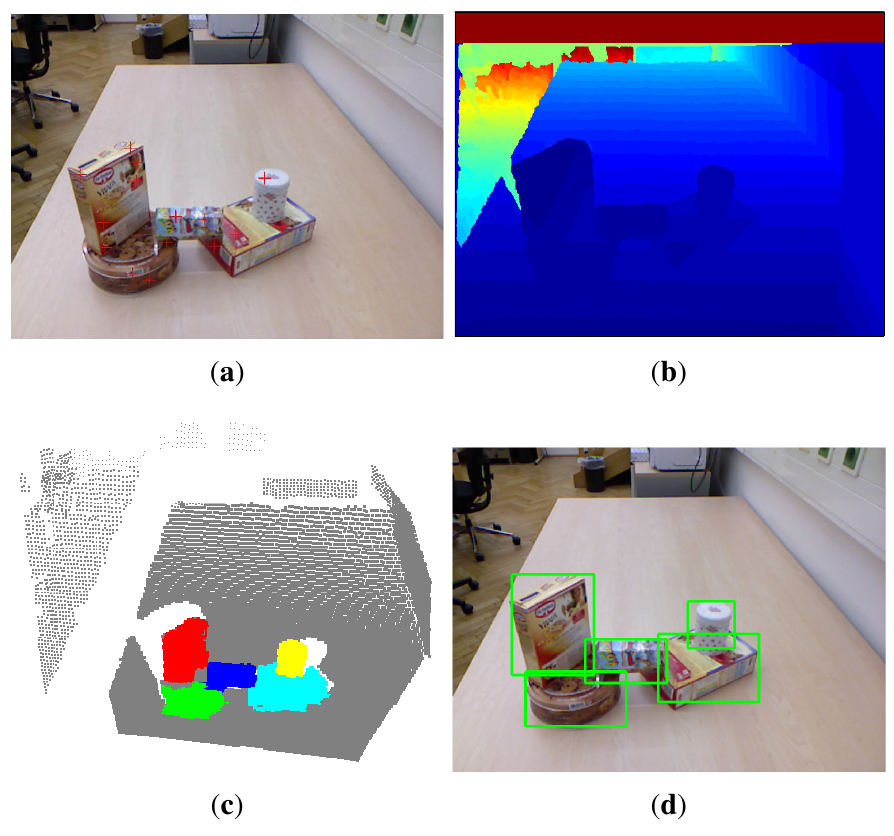
Figure 1. Given an RGB image ( a ) along with per-pixel depth information, ( b ) captured by an RGB-D camera, we detect possible positions (denoted by red plus) of previously unseen objects in a biologically-inspired way, generate and model object hypotheses, segment RGB-D objects in a multi-class labeling framework and, finally, refine the detected objects. The object detection result for the input scene is shown as a colored point cloud ( c ), where the background has gray color, while the detected objects have other colors, respectively. ( d ) Shows the detected objects with bounding